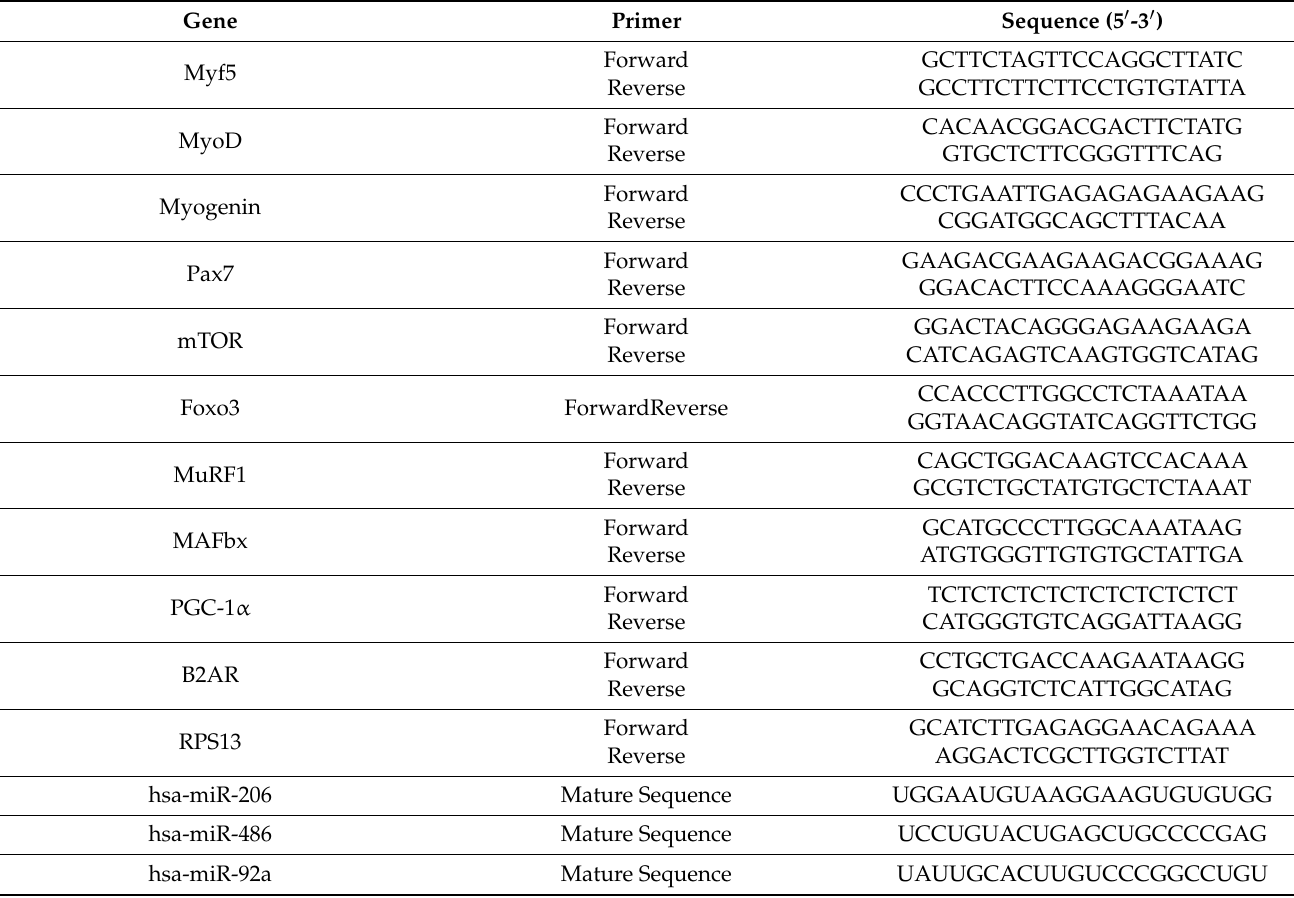
Table 1. Primer sequences used for assessing gene and miRNA